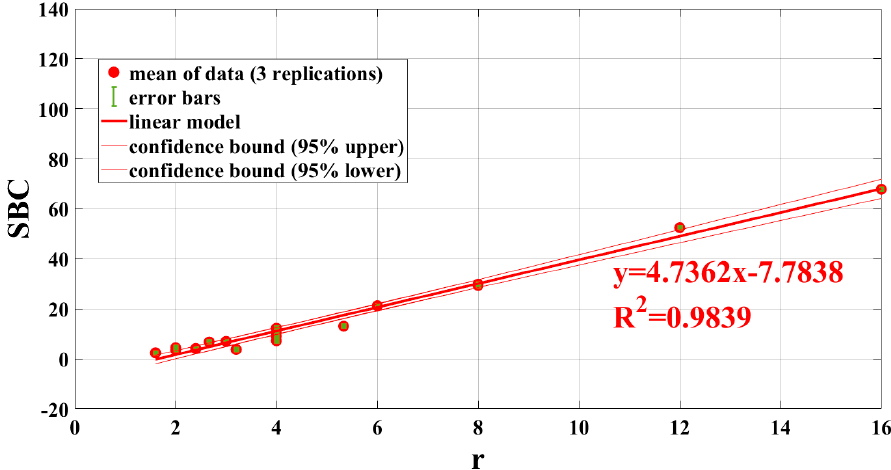
Figure 16. SBC versus r for PPT (amplitude) 512 frames (0.3906 Hz), error bands and confidence bounds on the find linear model.